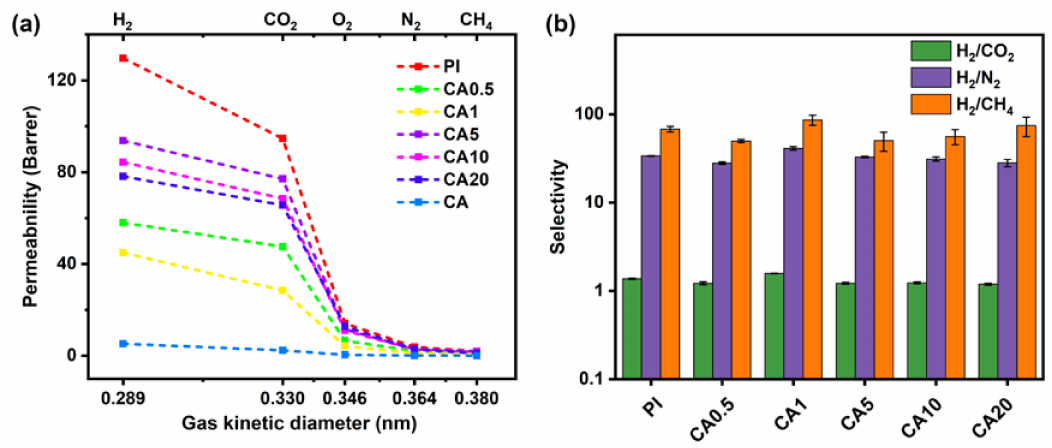
Figure 4. Gas permeability ( a ) and selectivity ( b ) of composite membranes with different content of CA.